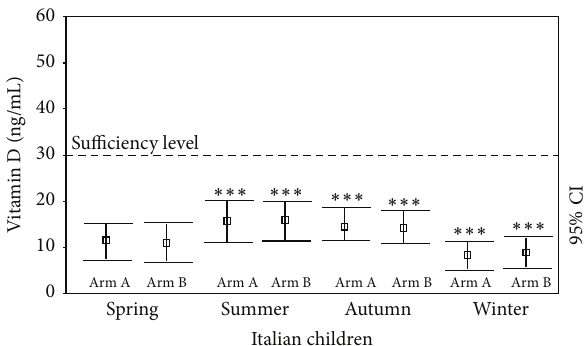
Figure 3: Seasonal variation in 25(OH)D levels (ng/mL) in Italian children and adolescents with 25(OH)D deficiency at baseline ( 𝑇 0 ) evaluation (versus spring value) in Arm A and Arm B. ∗ 𝑃 < 0.05 ; ∗∗ 𝑃 < 0.005 ; ∗∗∗ 𝑃 < 0.001 .